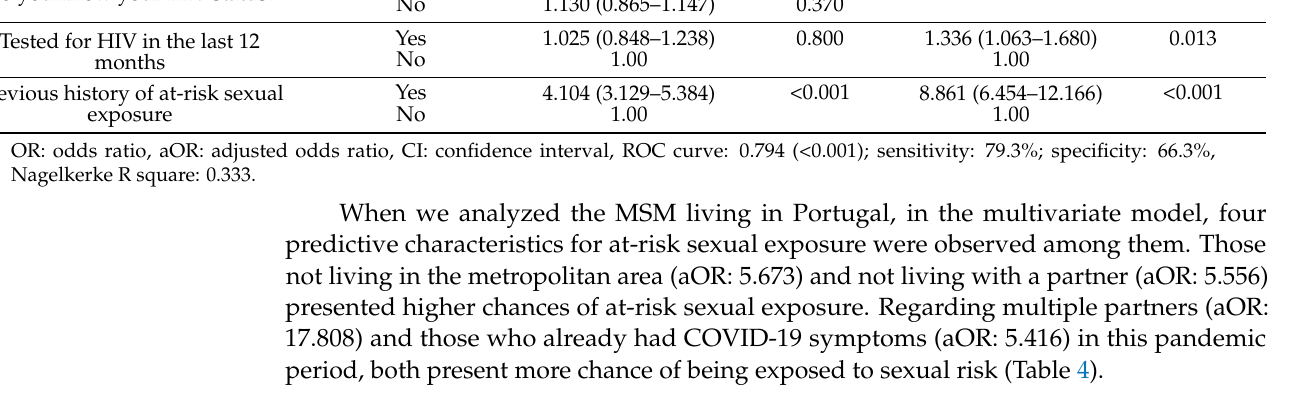
Table 4. Bivariate and multivariate analysis considering the factors associated with at-risk sexual exposure during the pandemic among the individuals living in Portugal,